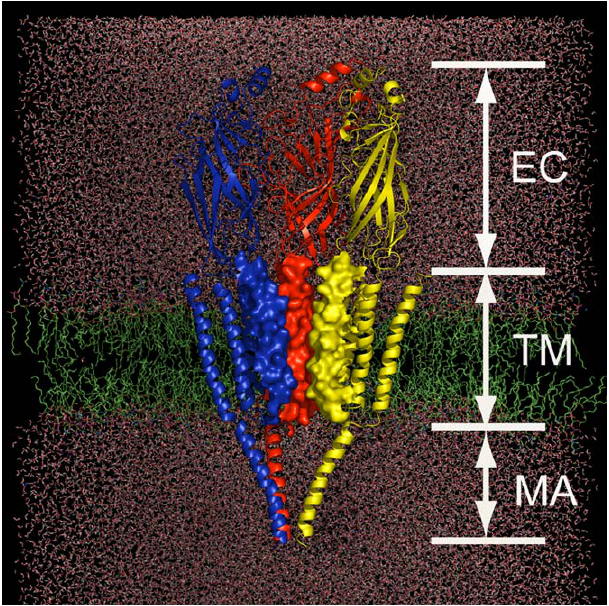
Figure 1. Schematic Representation of the Simulation System Con- structed on the Basis of the Cryo-EM Structure of nAChR at 4 A˚ Resolution nAChR is embedded in a DPPC lipid bilayer (green) and water molecules (red). Only three subunits (color-coded in red, blue, and yellow) are displayed for clarity. The M2 helices are rendered with electrostatic potential surface to highlight the pore